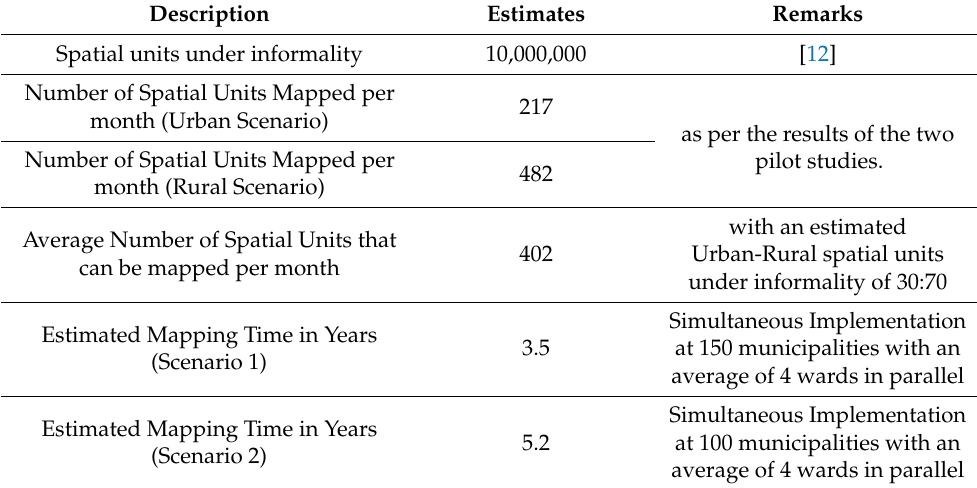
Table 1. Time estimation for nationwide mapping of informal lands using the FFLA